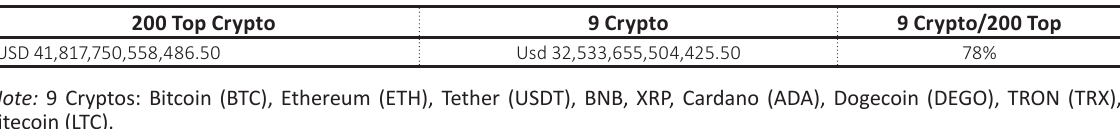
Table 4. Comparison of crypto capitalization